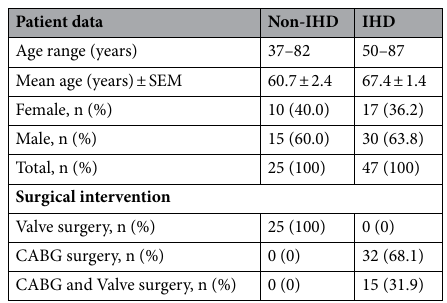
Table 1. Clinical characteristics of the patients. CABG , coronary artery bypass graft; IHD , Ischemic heart